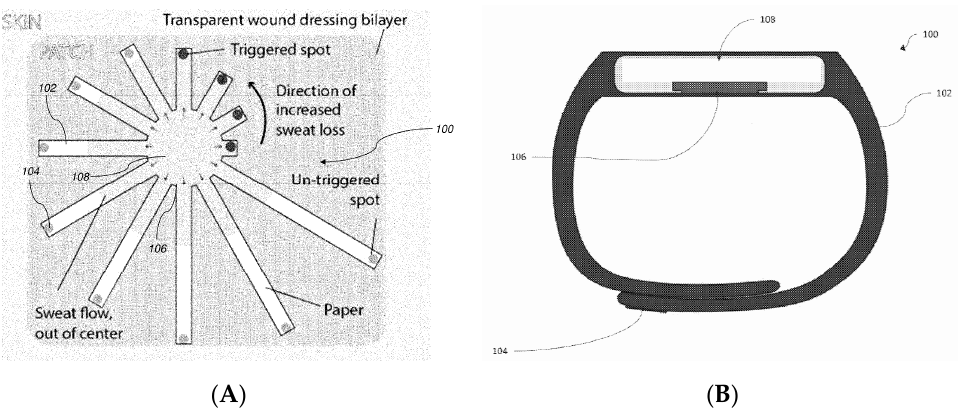
Figure 37. ( A ) The patch (100) claimed by [105] is based on cellulose fibers comprising radial channels (102) for sweat collection, carrying dyes at the end of the channels (104) for reading, and made of a wicking material (106) such as cellulose acetate or nitrocellulose laminated between two polymer films. The central collecting region (108) is made of the same material. ( B ) Wristband device claimed by Lansdorp et al. [106]. (100): whole device; (102) wristband; (104): wristband fastener; (106) sensor cartridge; (108) device body containing electronics.